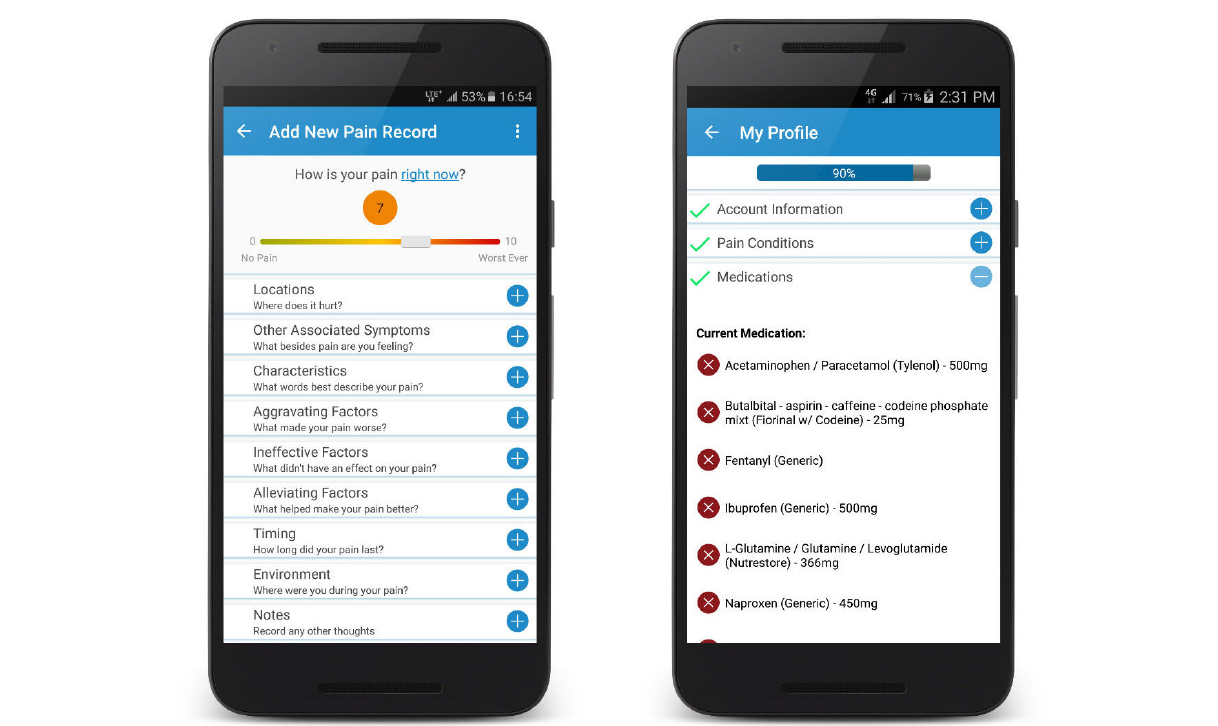
Figure 1. Screenshots of Manage My Pain showing how pain episodes are recorded (left) and where users can capture information about themselves